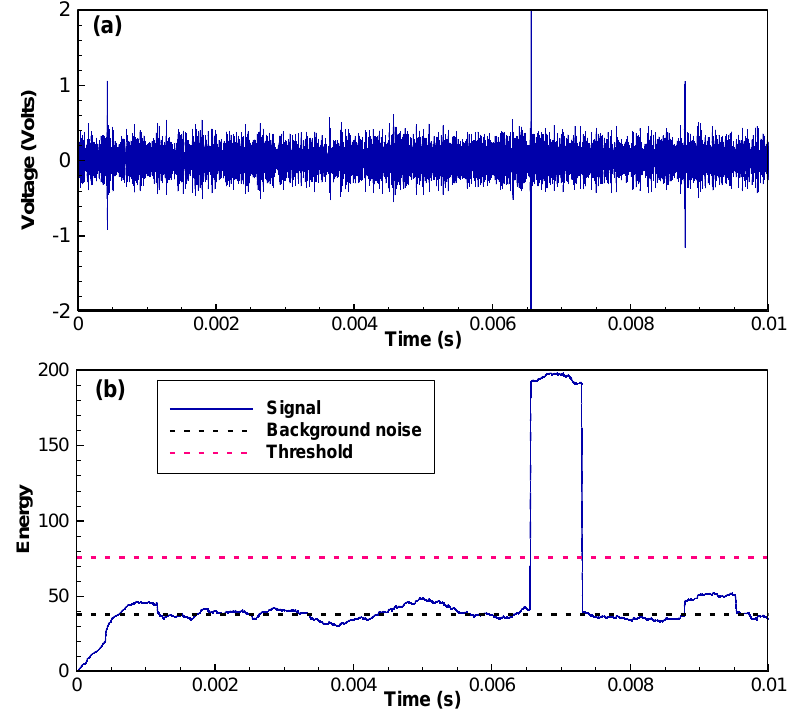
Figure 5. Correlation of an impulse noise that does not pass the JSATS detector: (a) wave; (b) cross-correlation.